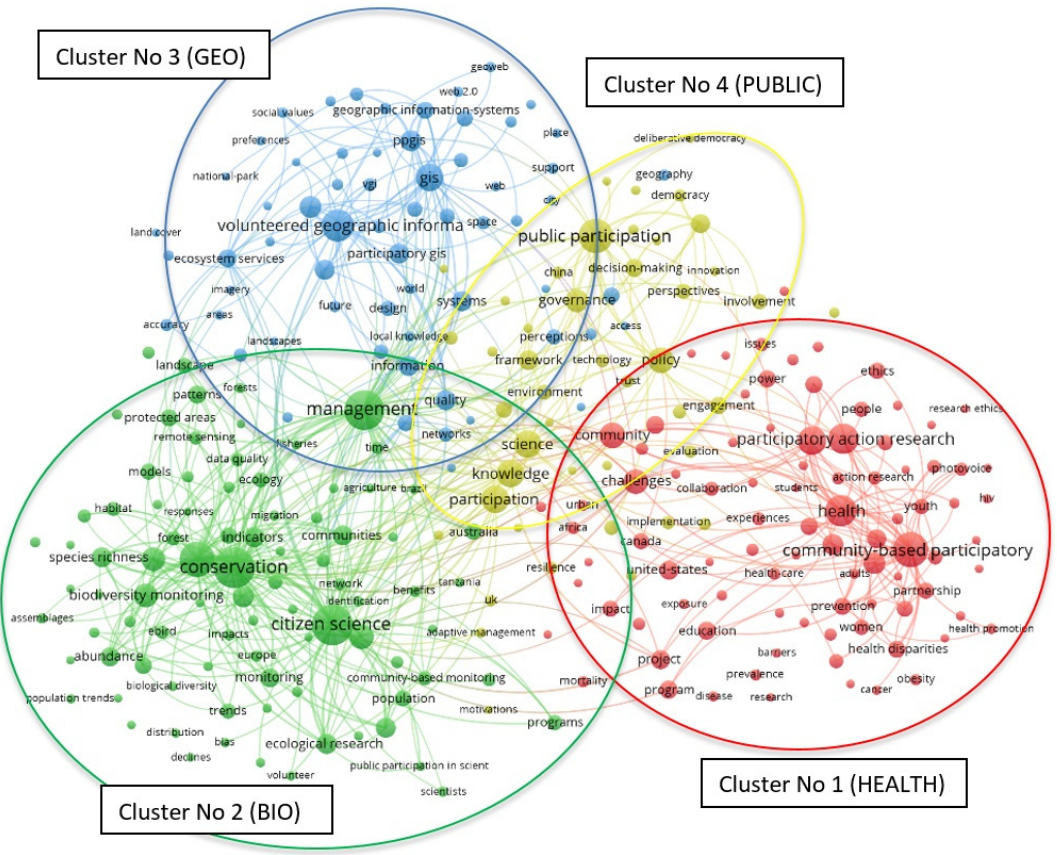
Figure 5. Co-occurrence map of subject areas with ≥ 15 documents on citizen science (CS) across the entire period.